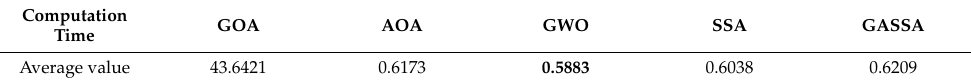
Table 8. Average computation time (in seconds) of 5 algorithms on the simulation